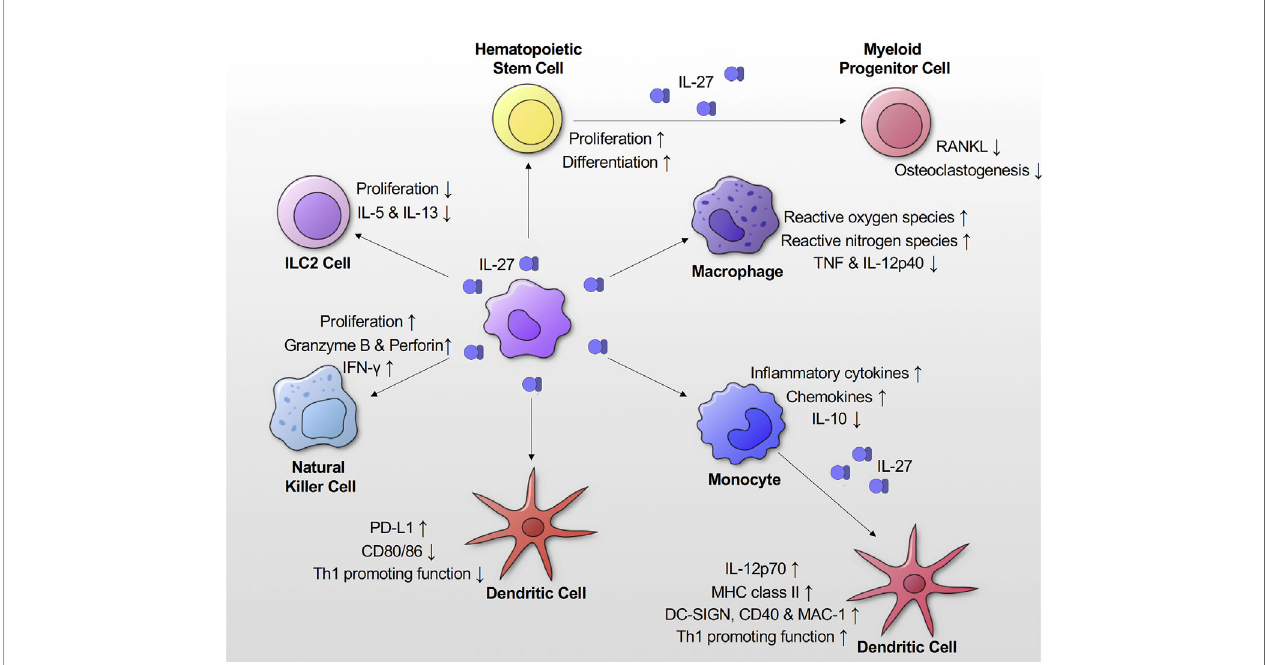
FIGURE 3 | Effects of IL-27 signaling on innate immune responses. IL-27 signaling promotes proliferation and differentiation of hematopoietic stem cells. It also suppresses osteoclastogenesis. IL-27 signaling suppresses Th2 cytokines (IL-5 and IL-13) production and proliferation of ILC2 cells. IL-27 in concert with IL-15/IL-18 enhances proliferation of NK cells and production of IFN- g , granzyme B and perforin by them. IL-27 promotes production of in fl ammatory cytokines and chemokines by monocytes. When DCs are differentiated from monocytes in the presence of IL-27 they show higher expression of MHC class II, DC-SIGN, CD40 and MAC-1. They also have increased production of IL-12. IL-27 enhances expression of PD-L1 on DCs, which show a reduced proliferation capacity and IFN- g